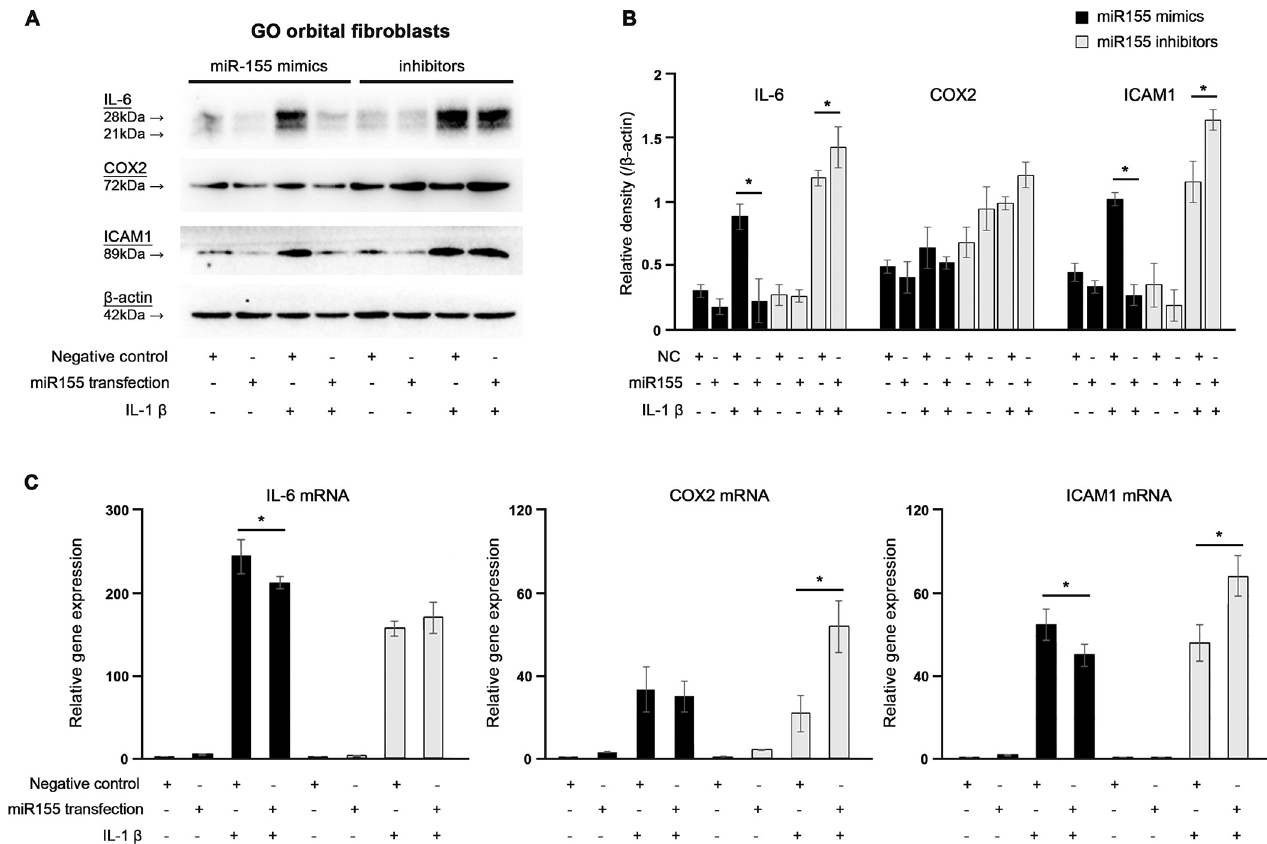
Fig 3. Effects of microRNA-155 mimics and inhibitors on interleukin (IL)-1 β induced IL-6, cyclooxygenase (COX)-2, and intercellular adhesion molecule (ICAM)-1 protein and mRNA expression in Graves’ orbitopathy (GO) (n = 4) orbital fibroblasts (OFs). (A, B) IL-1 β -induced IL-6 and ICAM1 protein production was reduced by miR-155 mimics, and increased by miR-155 inhibitors, respectively. ( � P < 0.05) (C) IL-1 β -induced IL-6 and ICAM1 mRNA expression were reduced by miR-155 mimics, and IL-1 β -induced COX2 and ICAM1 mRNA expression was increased by miR-155 inhibitors. ( � P < 0.05) These experiments were performed at least three times using OFs from at least three GO patients. The results are expressed as the mean ± standard deviation of at least three individual samples, and the graphs are representative of three independent experiments.